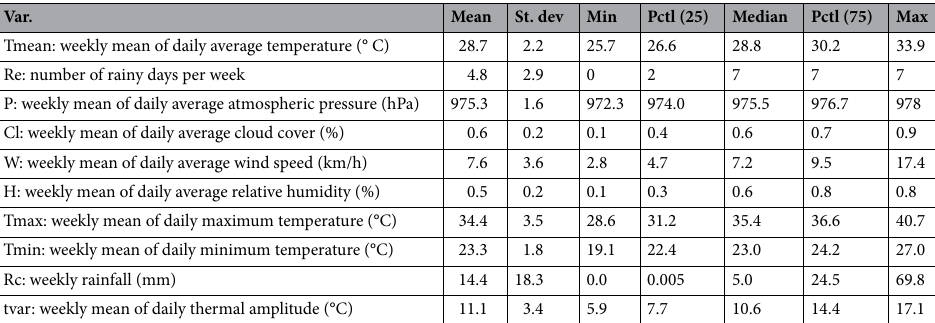
Var. Mean St. dev